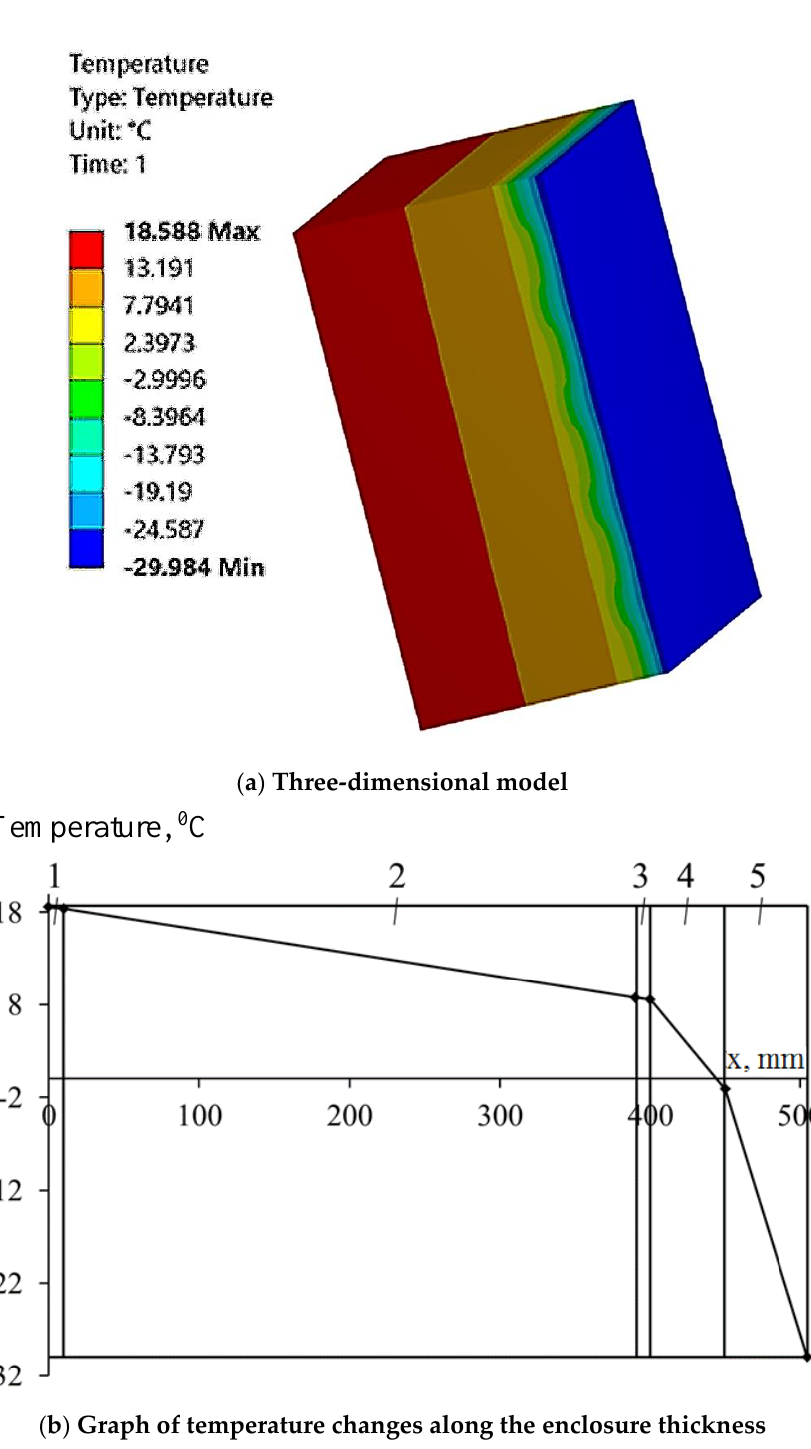
Figure 15. Temperature field in the enclosure at the absolute minimum ambient temperature: ( a ) — three-dimensional model; ( b ) — graph of temperature changes along the enclosure thickness in the cross section of the air channel: 1, 3 — cement-sand plaster; 2 — bearing layer from ceramic brick; 4 — closed air channel; 5 — insulant — extruded polystyrene foam with heat — reflecting screen. The temperature fields in the enclosure at the maximum ambient temperature, at the average temperature of the coldest five-day period with a probability of 0.92 and at the average temperature of April were calculated by a similar method, the results of which are presented in Table 10.